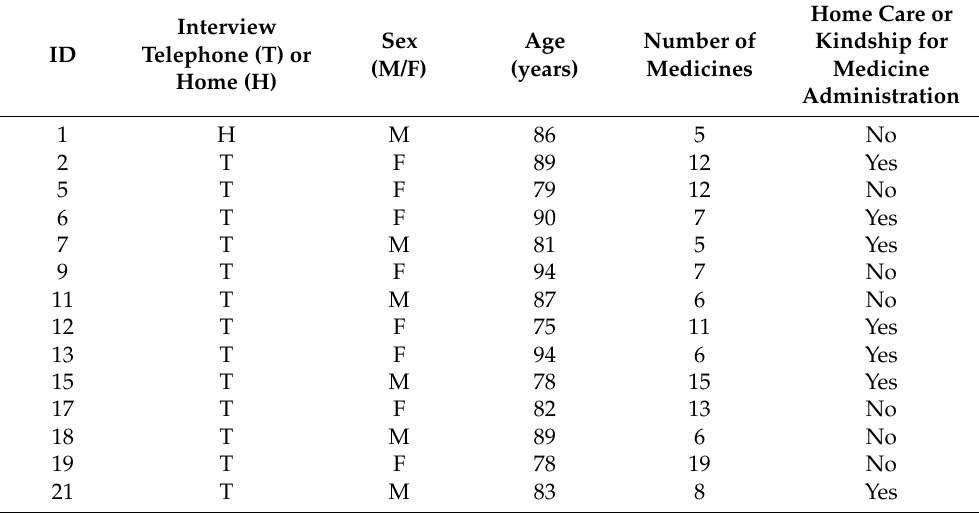
Table 1. Participant characteristics (patients).